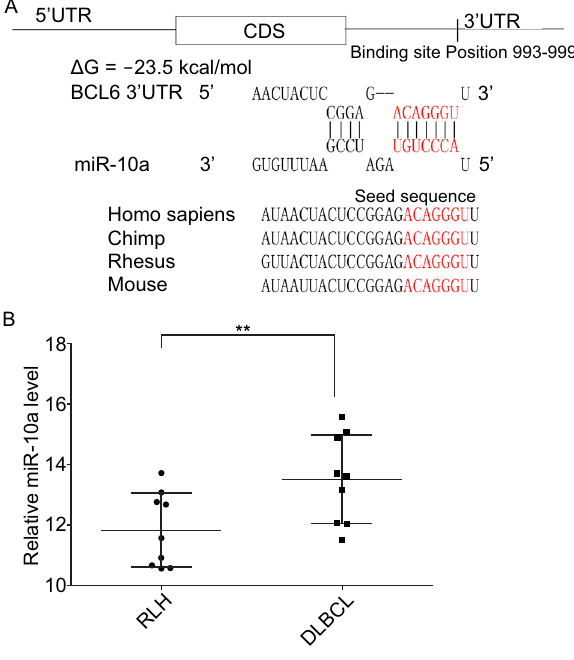
Figure 2. Schematic description of the hypothesized and miR-10a in human tissues. (A) Schematic description of the hypothesized duplex formed by interaction between the BCL6 3 ′ -UTR (top) binding site and miR-10a (bottom). The predicted free energy value of the hybrid is indicated. The seed recognition site is denoted, and all nucleotides in this region are highly conserved across species, including Homo sapiens, chimp, rhesus, and mouse. (B) Quantitative RT-PCR analysis of the expression levels of miR-10a, the relative expression levels were analyzed using Δ Ct values ( Δ Ct = Ct miR-10a − Ct U6 ). The U6 gene served as the endogenous control in diffuse large B-cell lymphoma(DLBCL) and reactive lymph node hyperplasia (RLH) tissues. Data (mean ± SEM) are representative of 3 technique replicates. ** P <